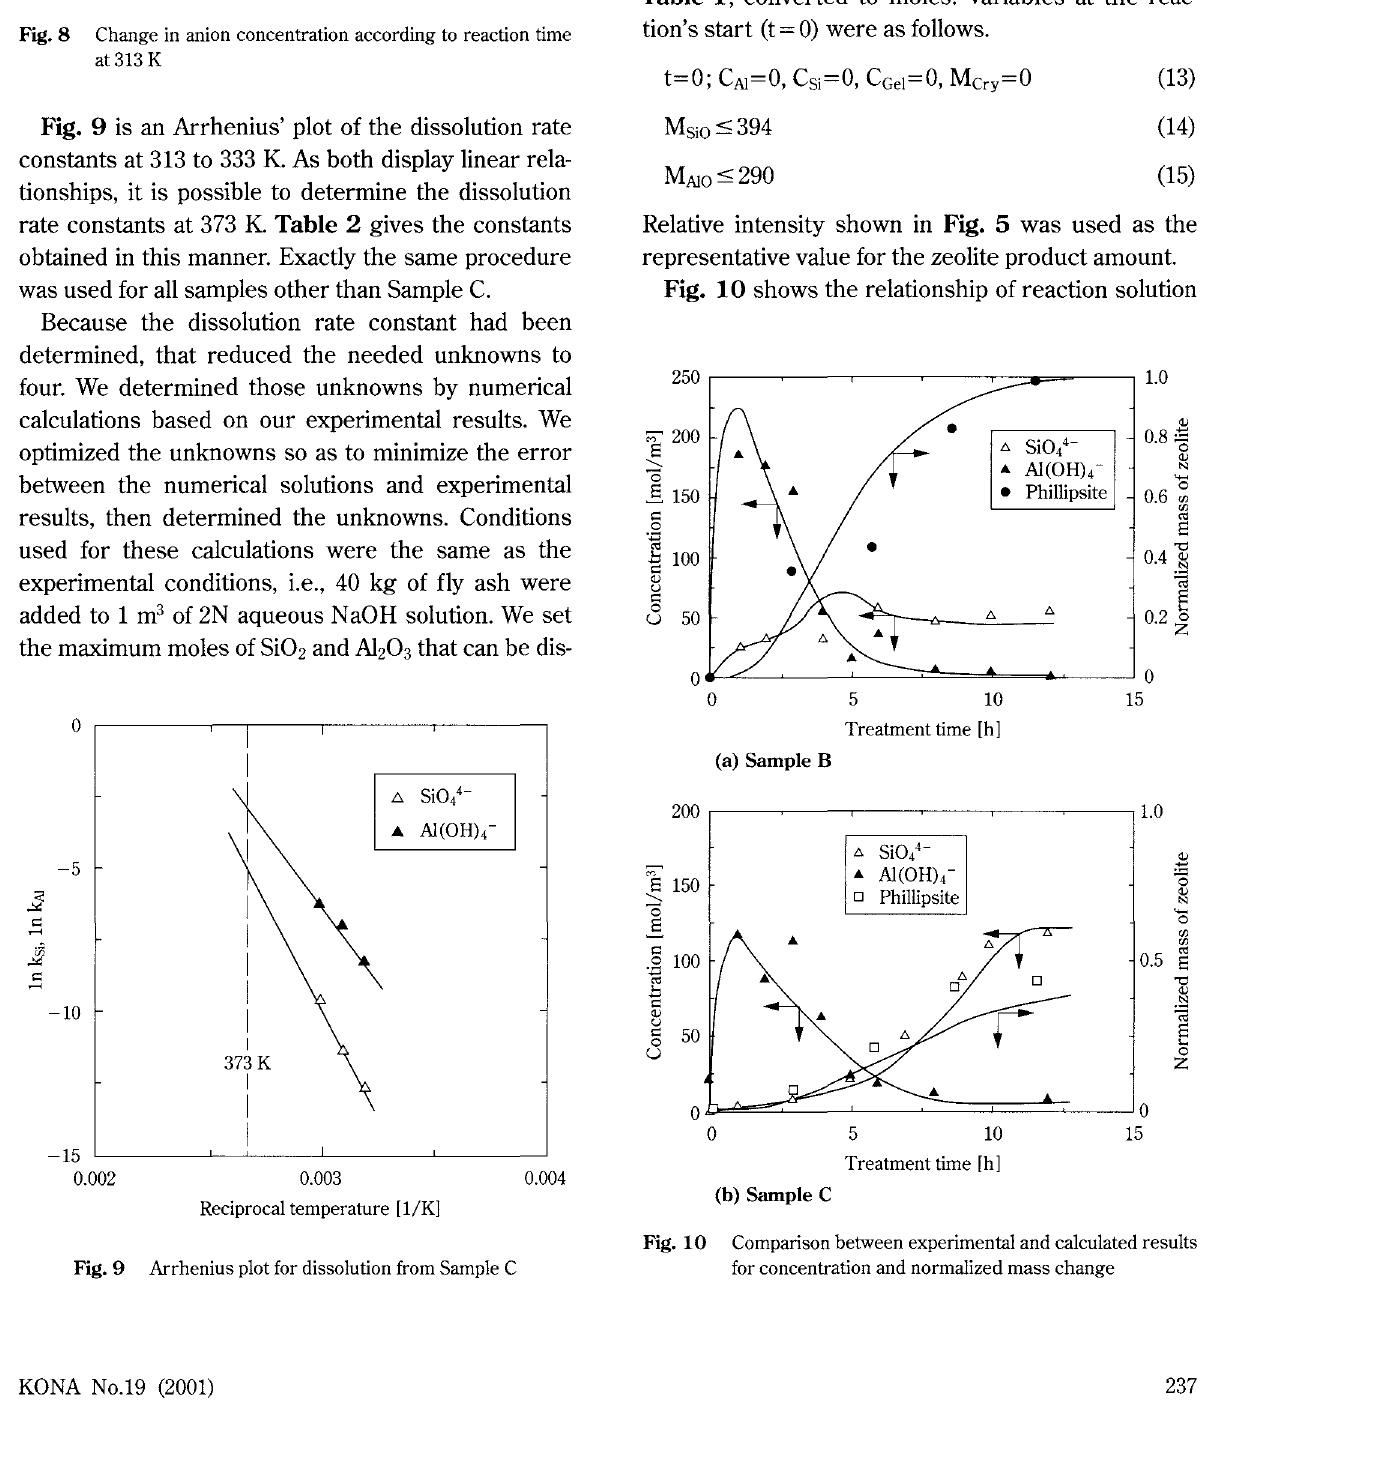
Fig. 9 Arrhenius plot for dissolution from Sample C